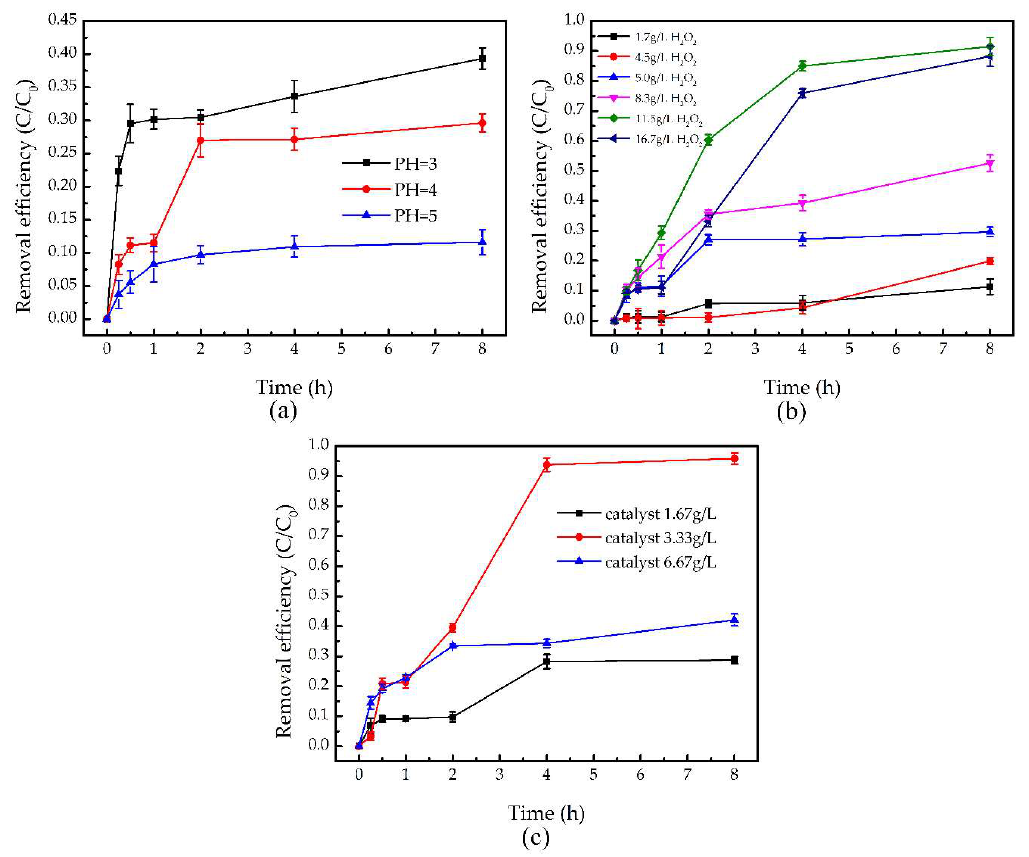
Figure 4. Effect of ( a ) the initial pH, ( b ) the H 2 O 2 concentration and ( c ) the catalyst dosage on TCE degradation. Reaction conditions: ( a ) [TCE] 0 = 1.46 g/L, [Goethite] = 3.33 g/L, [H 2 O 2 ] 0 = 8 g/L, T = 293 K; ( b ) [TCE] 0 = 1.46 g/L, [Goethite] = 3.33 g/L, pH = 4, T = 293 K; ( c ) [TCE] 0 = 1.46 g/L, [H 2 O 2 ] 0 = 8 g/L, pH = 4, T = 293 K.